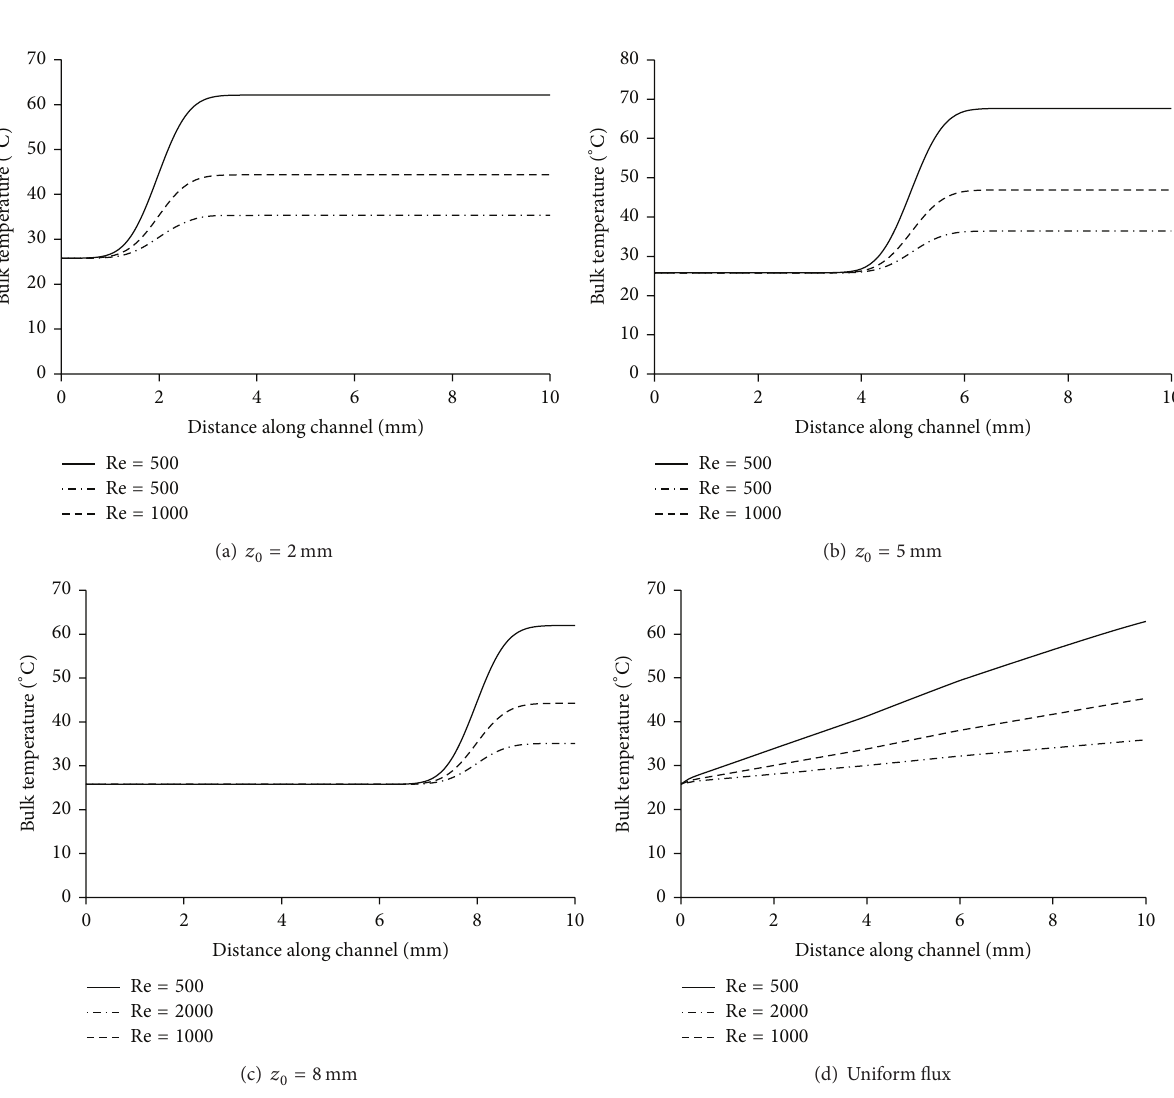
temperature at the channel exit is insignificant, as shown in Figures